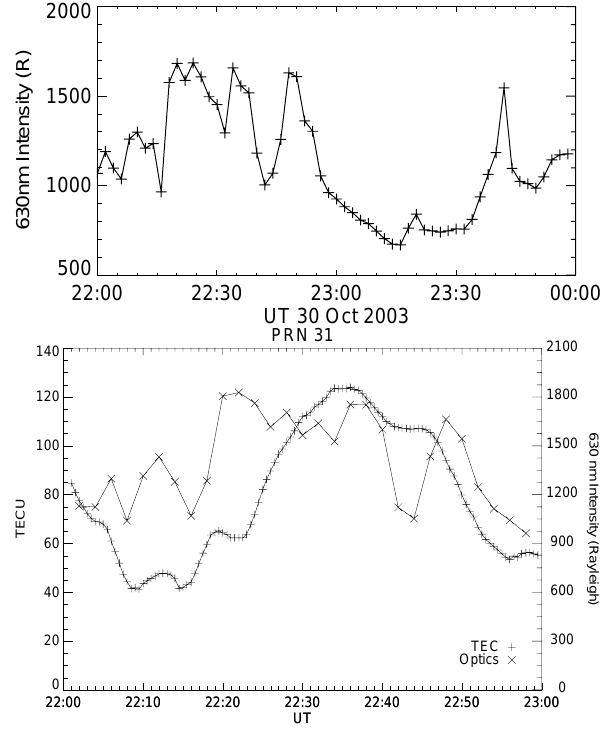
Fig. 8. 630.0nm emission intensities in the vertical between 22:00 and 24:00UT over Qaanaaq (upper panel) and optical emissions as observed from Qaanaaq (marked with Xs) compared with GPS TEC measurements from Thule, Greenland (plus symbols) approx- imately 100km south of Qaanaaq (lower